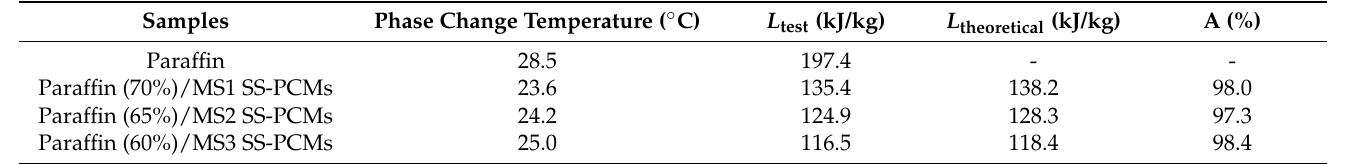
Table 2. Thermophysical properties of paraffin and paraffin/MS SS-PCMs.